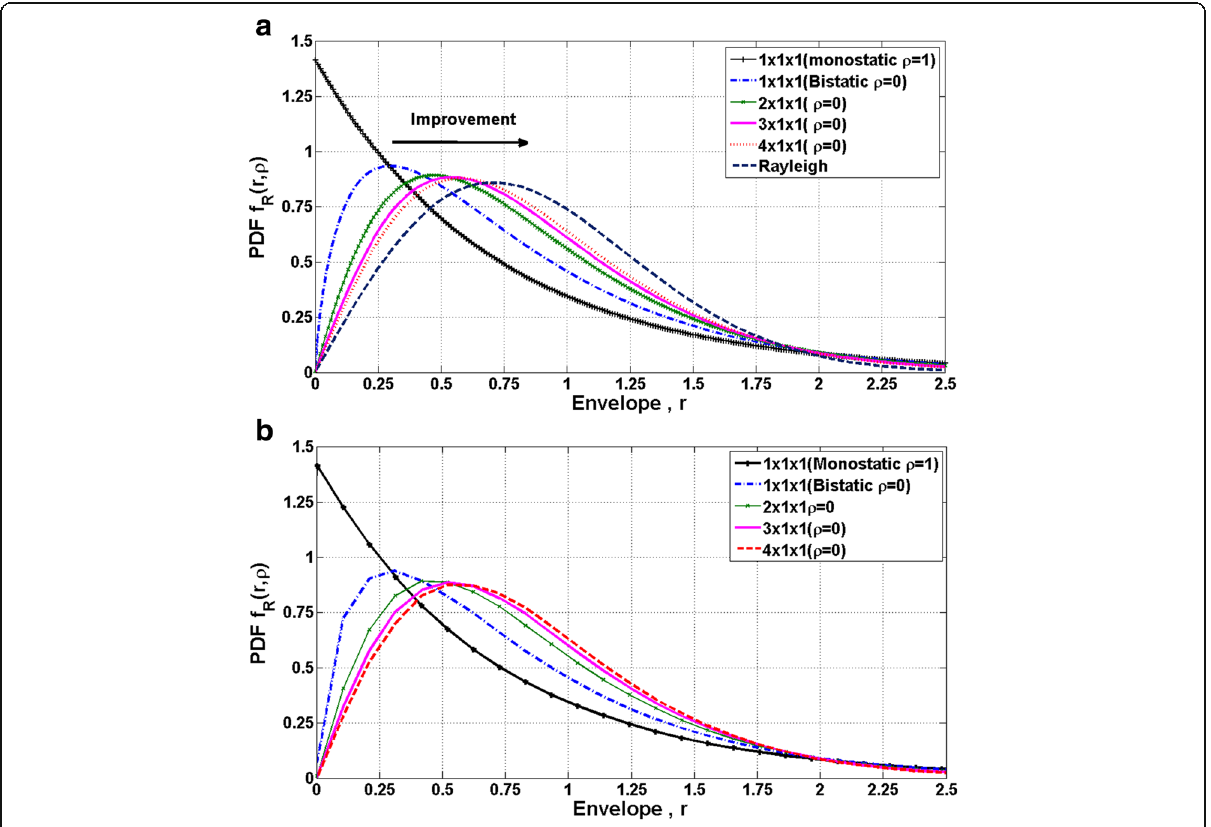
Fig. 4 PDF of backscatter channel by increasing the number of co-phased TX transmitters. a PDF results from analytical expressions for M = 1, 2, 3,4 transmitters with the proposed phase adjustment and coherent transmitter (the PDF for monostatic, bistatic, and Rayleigh are also illustrated for comparison). b The numerical results of PDF with channel